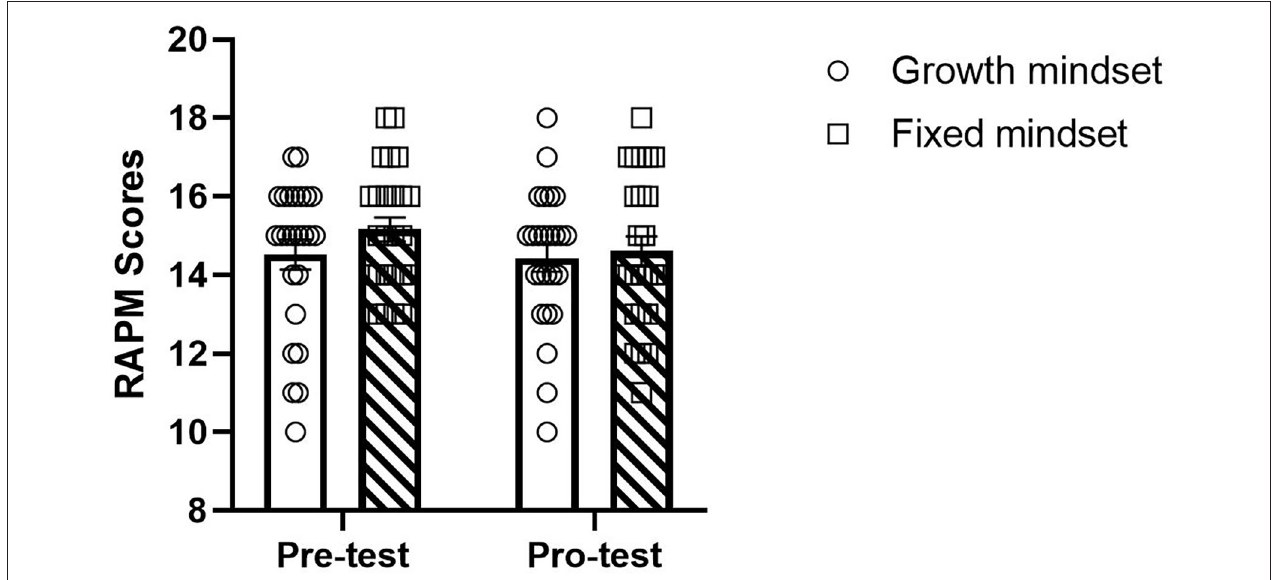
FIGURE 6 | The difference between the fixed group and the growth group in Raven’s Advanced Progressive Matrices